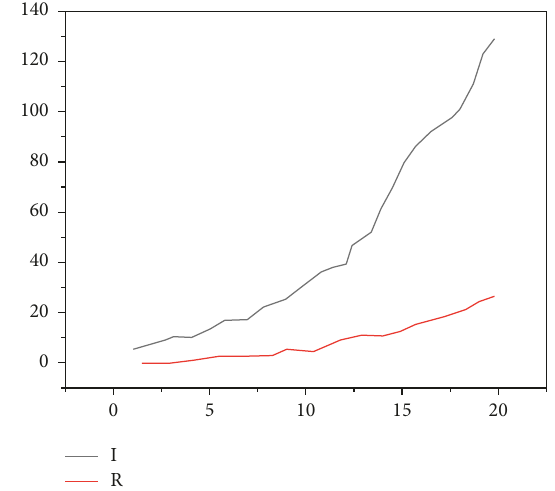
Figure 2: Particle swarm optimization model.